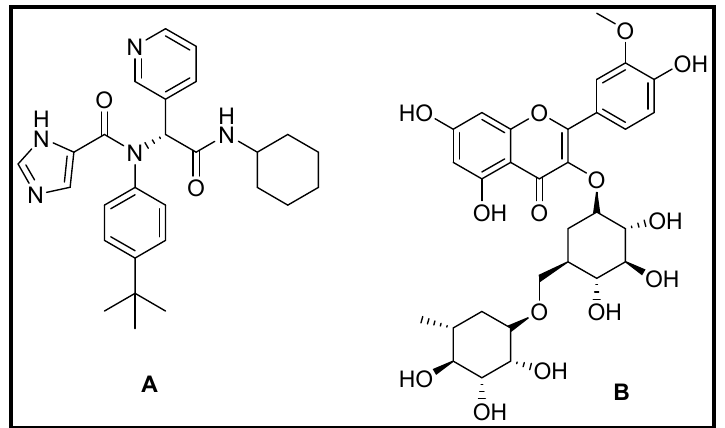
Figure 8. Chemical structure of standard inhibitor 10 ( A ) and narcissoside ( B ).